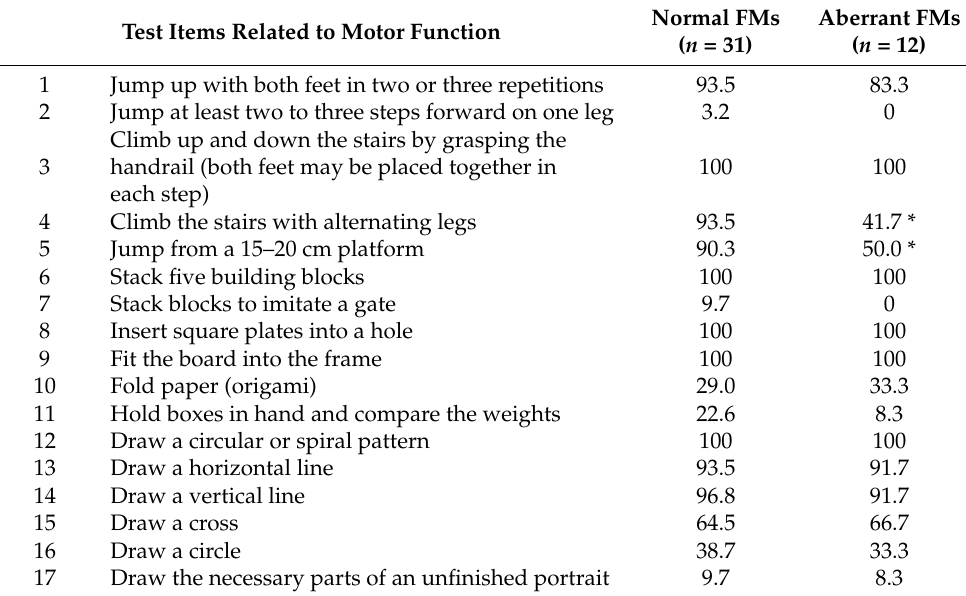
Table 3. Percentage of subjects who were able to complete the